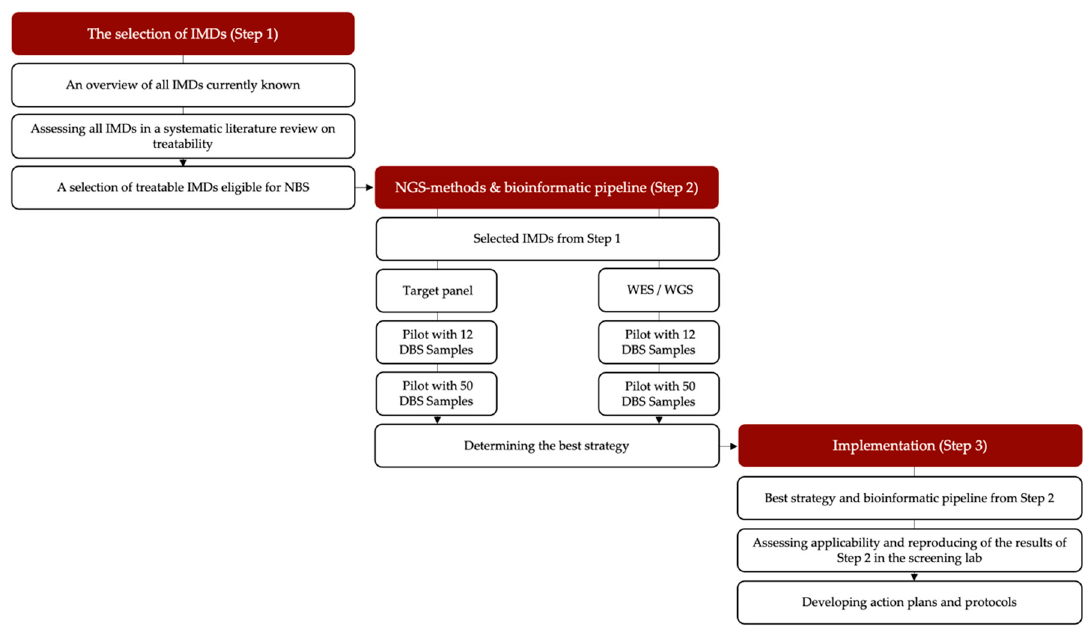
Figure 1. Overview of the study set-up. IMD = inherited metabolic disorder, NGS = next-generation sequencing, DBS = dried blood spot, WES/WGS: whole exome sequencing/whole genome sequenc- ing.